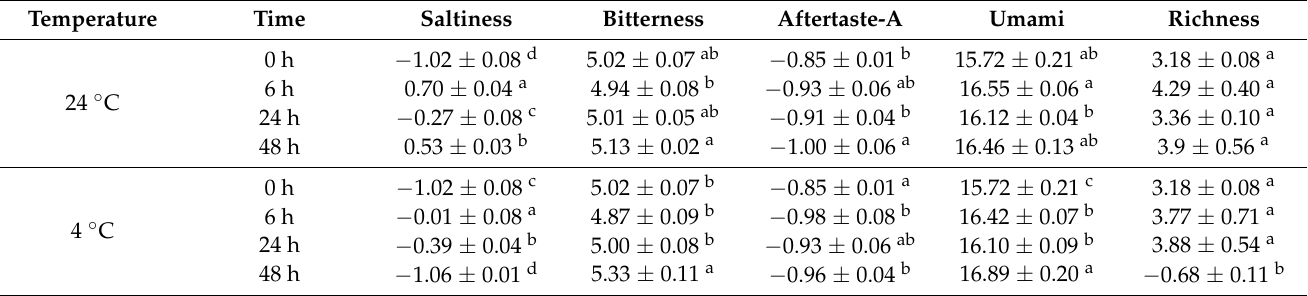
Table 9. Taste profiles of American shad muscle at 24 ◦ C (unrefrigerated) and 4 ◦ C